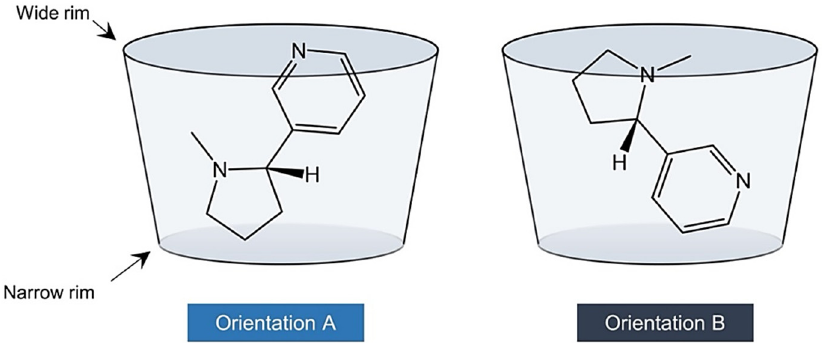
Figure 2. Schematic illustration of two possible conformations of the nicotine/CDs inclusion com- plex.